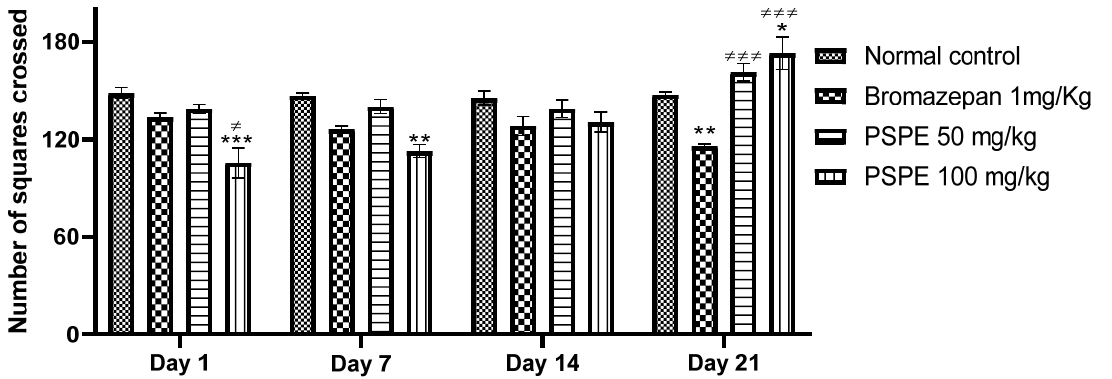
Figure 5. Variation in the number of tiles traversed during the open-field test over the four weeks of treatment in control and treated mice (* p ≤ 0.05, ** p ≤ 0.01, *** p ≤ 0.01 in comparison to negative controls, ≠ p ≤ 0.05, ≠≠≠ p ≤ 0.001 in comparison to positive controls). PSPE: Polyphenolic fraction of P. sativum